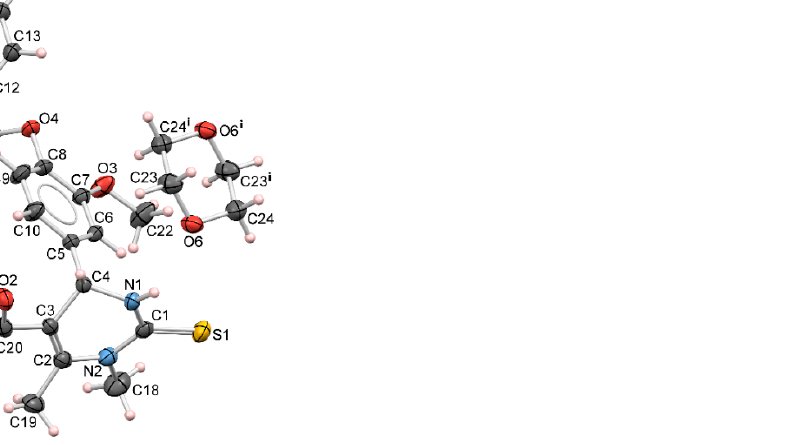
Figure 1. MERCURY [29] drawing of the molecular structure of compound 4j with labeled non-H atoms. Displacement ellipsoids are shown at 30% probability. Symmetry code: (i) − x , − y+1 , − z+2 .